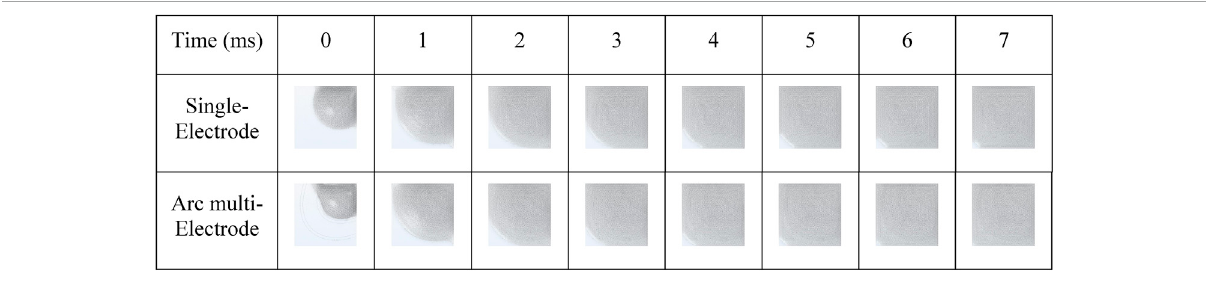
TABLE 5 Oil movement between arc multi-electrode and single-electrode in the pixel closing